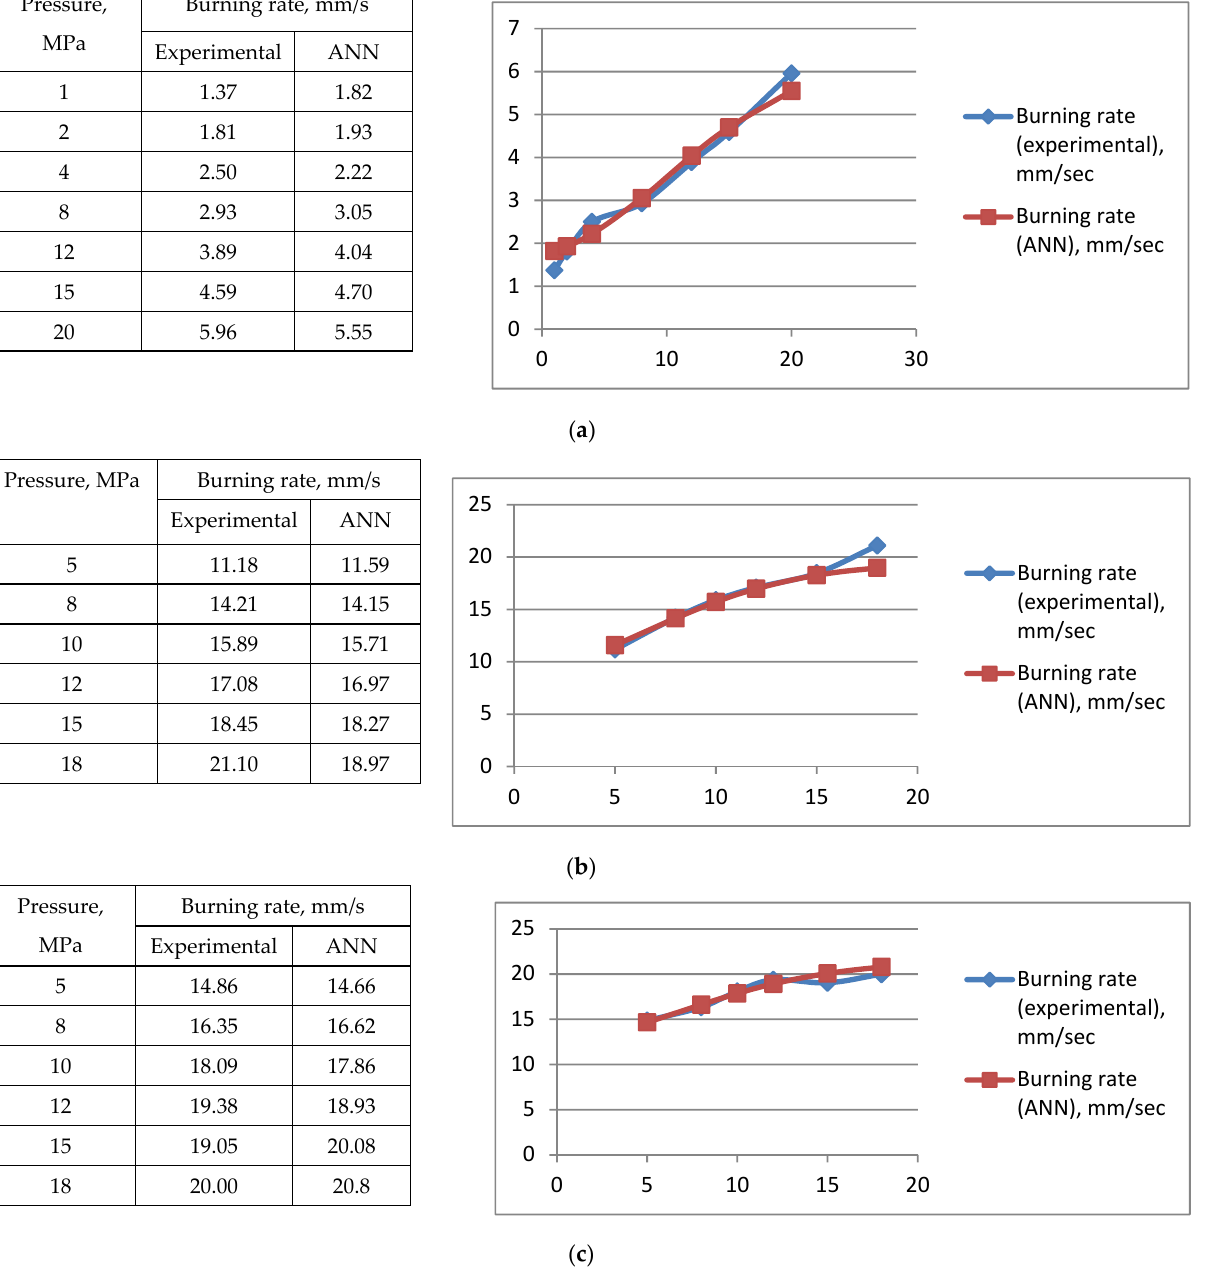
Figure 10. Comparison curves of predicted burning rate with experimental data of solid propellants. ( a ): 73.5% NG/NC + 19.5% burning rate inhibitor + 4.0% catalyst + 3.0% additives; ( b ): 63.0% NG/NC + 2.3% catalyst + 2.8% additives + 26% RDX + 4.6% diethyl phthalate (DEP) + 1.3% (nAlN); ( c ):